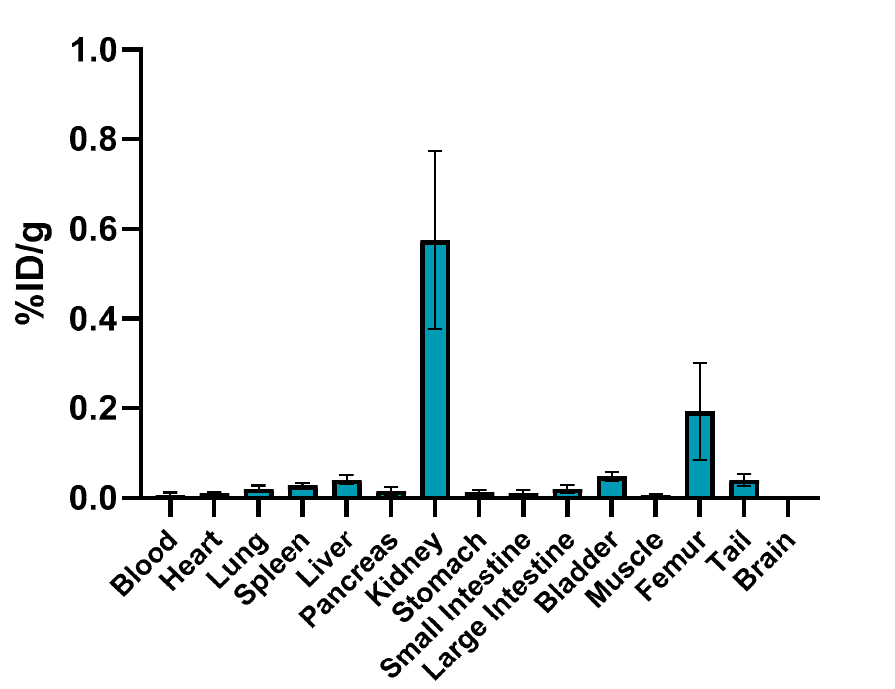
Figure 5. Biodistribution data of 89 Zr-AAZTHAG on female healthy nude mice in selected organs measured 24 h p.i. The activity accumulated is reported as percentage of injected dose per gram (%ID/g ± SD) ( n = 3).